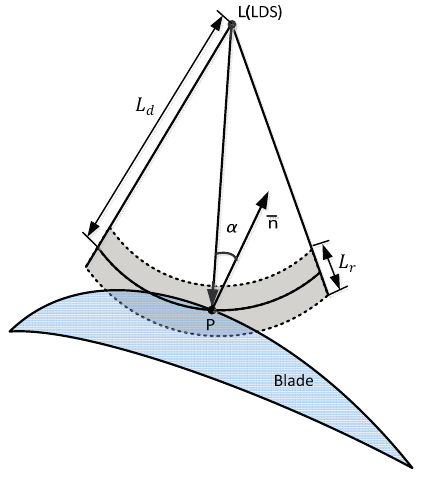
Figure 10. Schematic diagram of the LDS